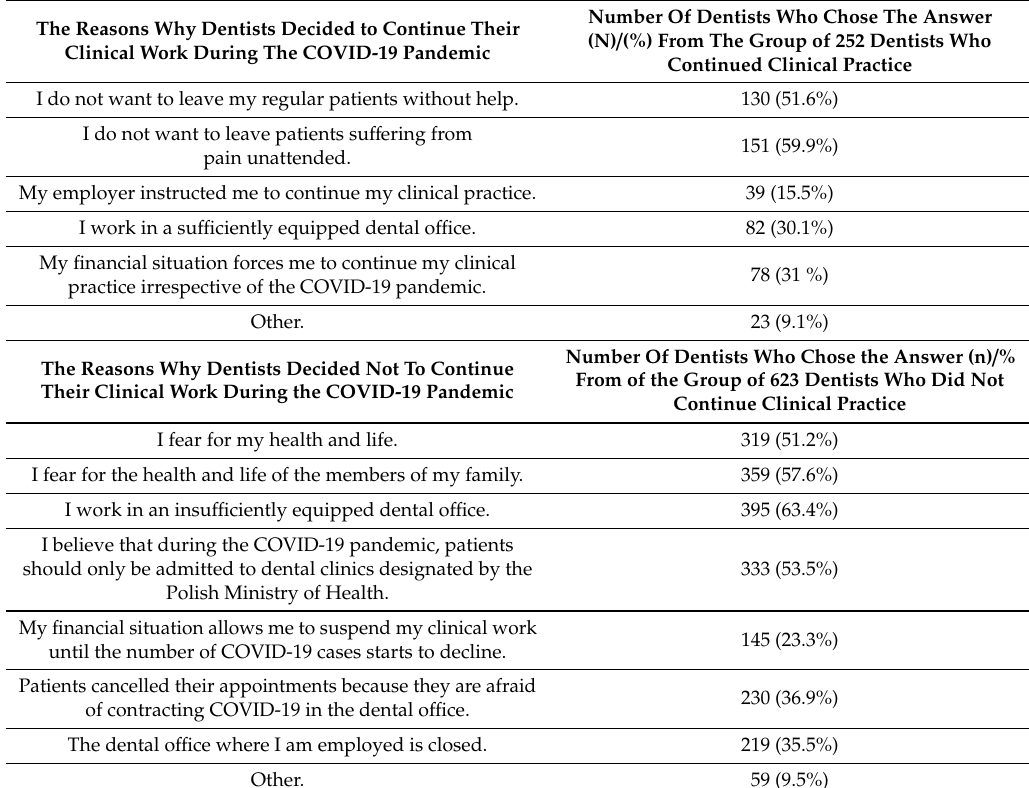
Table 2. Reasons for continuing or suspending clinical practice during the COVID-19 pandemic in